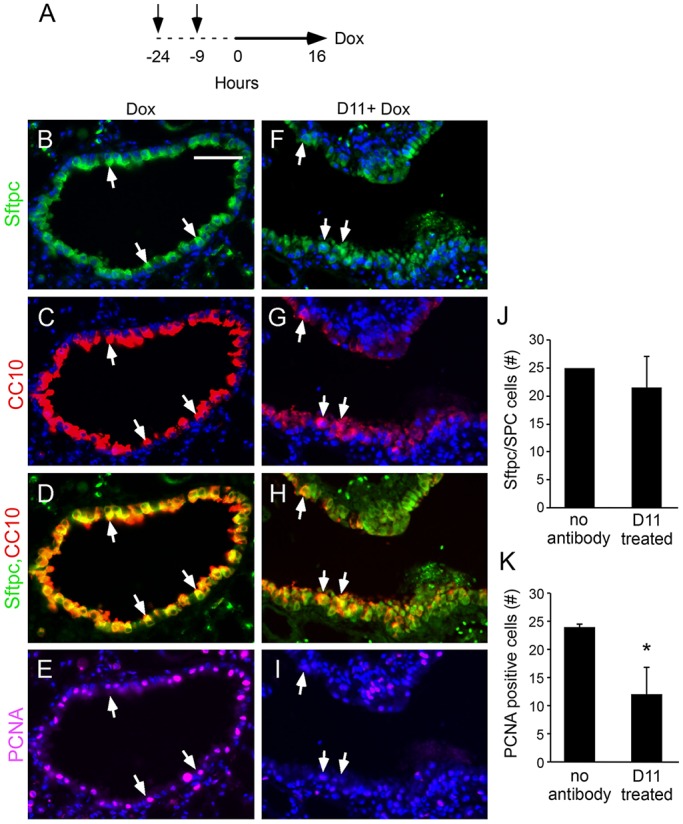
Inhibition of Sftpc+/CC10+ double-positive cell proliferation by the D11 antibody. (A) Experimental schematic. Arrows indicate D11 injections. Solid line indicates doxycycline treatment. (B-I) Immunofluorescence showing Sftpc, CC10 and PCNA expression as indicated in lung bronchioalveolar duct junction regions from Sftpc-rtTA, Tre-Fgf9-Ires-eGfp mice induced with doxycycline for 16 h. Control mice (B-E) were not injected and experimental mice (F-I) received two doses of D11 antibody injections prior to doxycycline induction. Arrows indicate examples of cells expressing all three markers. (J) Quantitation of the number of Sftpc+/CC10+ double-positive cells in the terminal bud region (defined as within 25 cells of the BADJ) (n=3 mice). (K) Quantitation of the ratio of PCNA-positive cells to Sftpc+/CC10+ double-positive cells in the terminal bud region (n=3 mice). Data plotted as mean±s.d., *P<0.002. Scale bar: 50 µm.